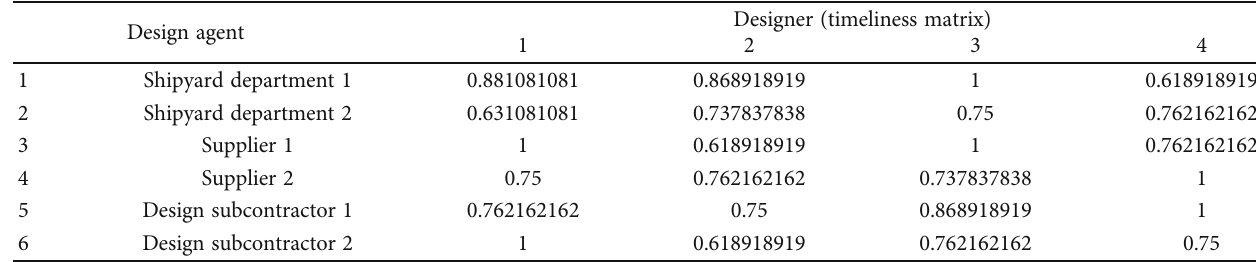
Table 13: Designer timeliness matrix- Q